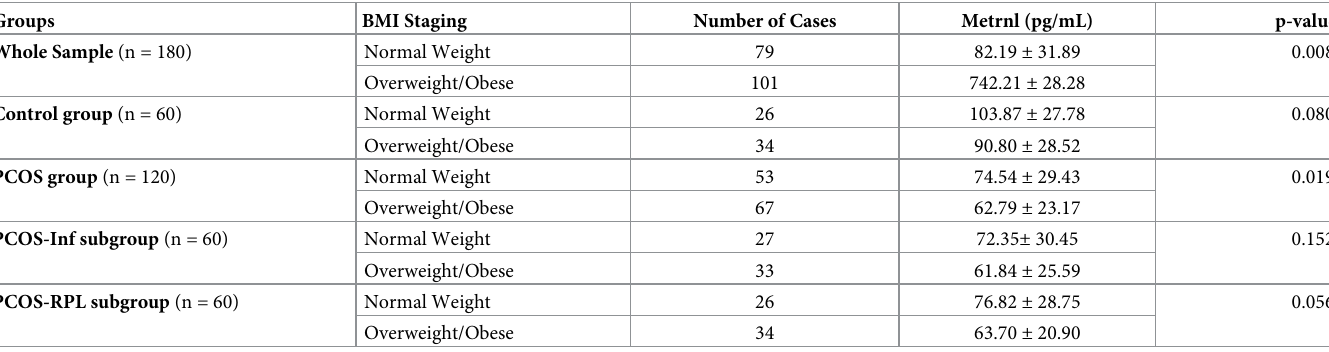
Obesity and adipose tissue dysfunction, as a part of MetS, are common in patients diagnosed with PCOS, adversely affecting their cardiometabolic function and systemic homeostasis Table 2. Mean comparison of serum Metrnl levels in normal ( < 25kg/m 2 ) and overweight/obese ( � 25 kg/m 2 ) patients.